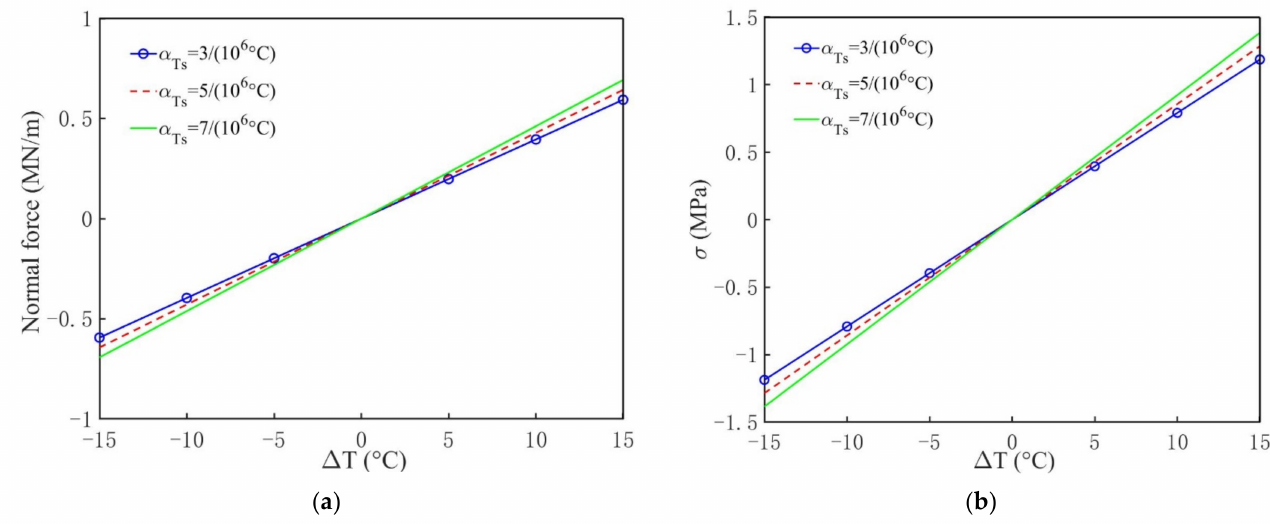
Figure 8. Impact of ∆ T on the internal forces of tunnel lining while considering different α Ts : ( a ) Normal force; ( b ) Stress of